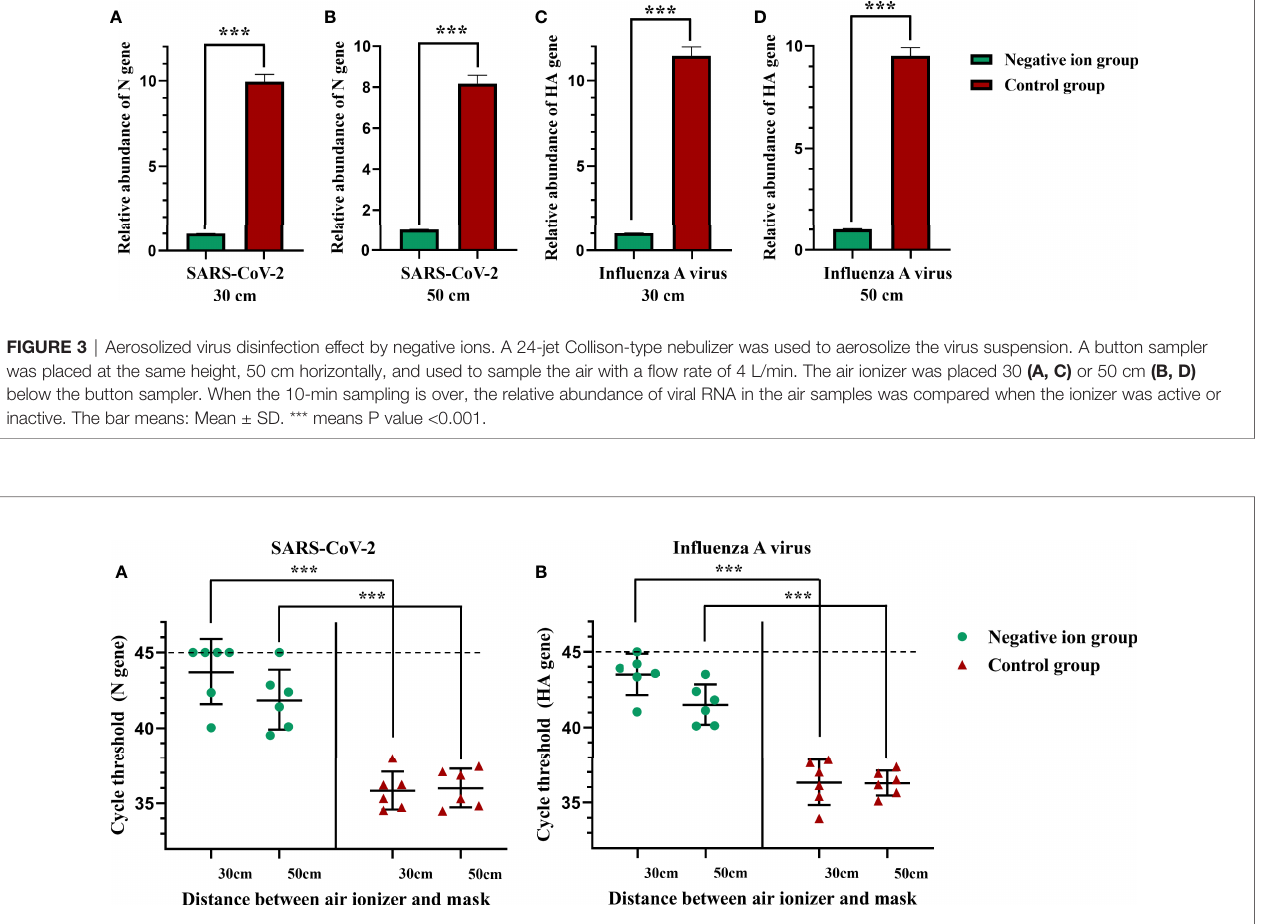
FIGURE 4 | Negative ions reduce the amount of viral nucleic acid that stuck on masks. Syndrome coronavirus 2 (SARS-CoV-2) (A) and in fl uenza A virus (B) . A mannequin of the upper body wearing a mask was facing the outlet of the nebulizer with a horizontal distance of 50 cm. The negative ionizer was 30 or 50 cm below the mouth of the mannequin. After 10 min of aerosol exposure, the mask was cut into 1 × 1-cm pieces, and six of them were vortex oscillated in 1 ml TRIzol for 5 min, and then the supernatant was used to extract RNA for viral nucleic acid testing. Dashed lines indicate no fl uorescence signal to the maximum cycle (45). The bar means: Mean ± SD. *** means P value